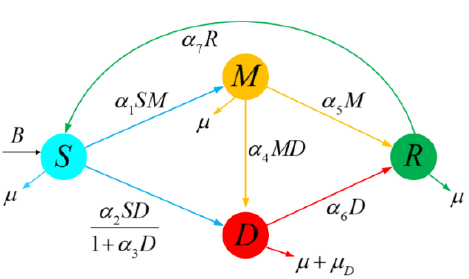
Figure 1. Schematic diagram of malaria-dengue